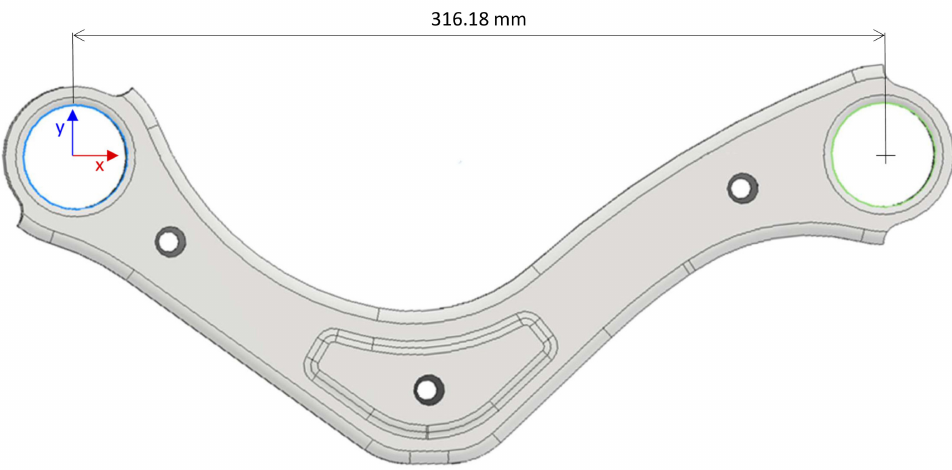
Figure 3. A welded part and the dimension to be examined.